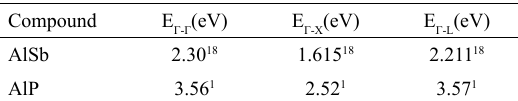
Table 1. Experimental bandgap energies for AlSb and AlP fixed in the fits. Compound